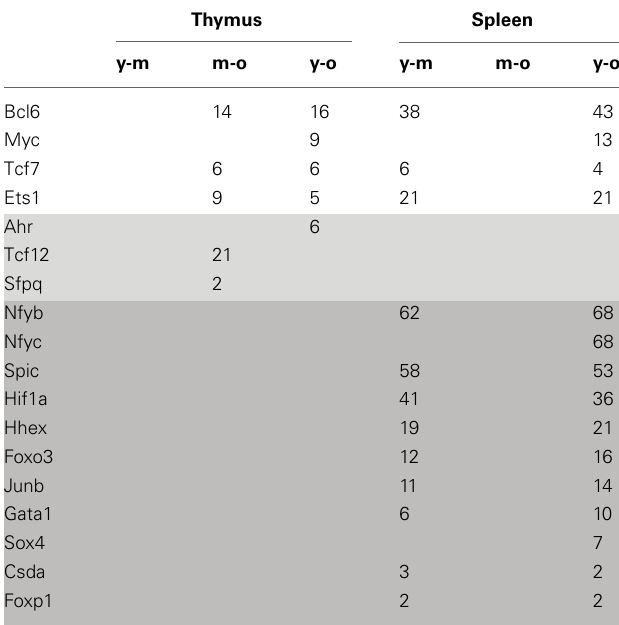
Number of target genes that correlate with transcription factor expression. The transcription factors shaded in white are commonly de-regulated in the thymus and spleen, light gray shading indicates the transcription factors with a thymus- specific expression pattern, and dark gray shading indicates transcription factors with a spleen-specific expression